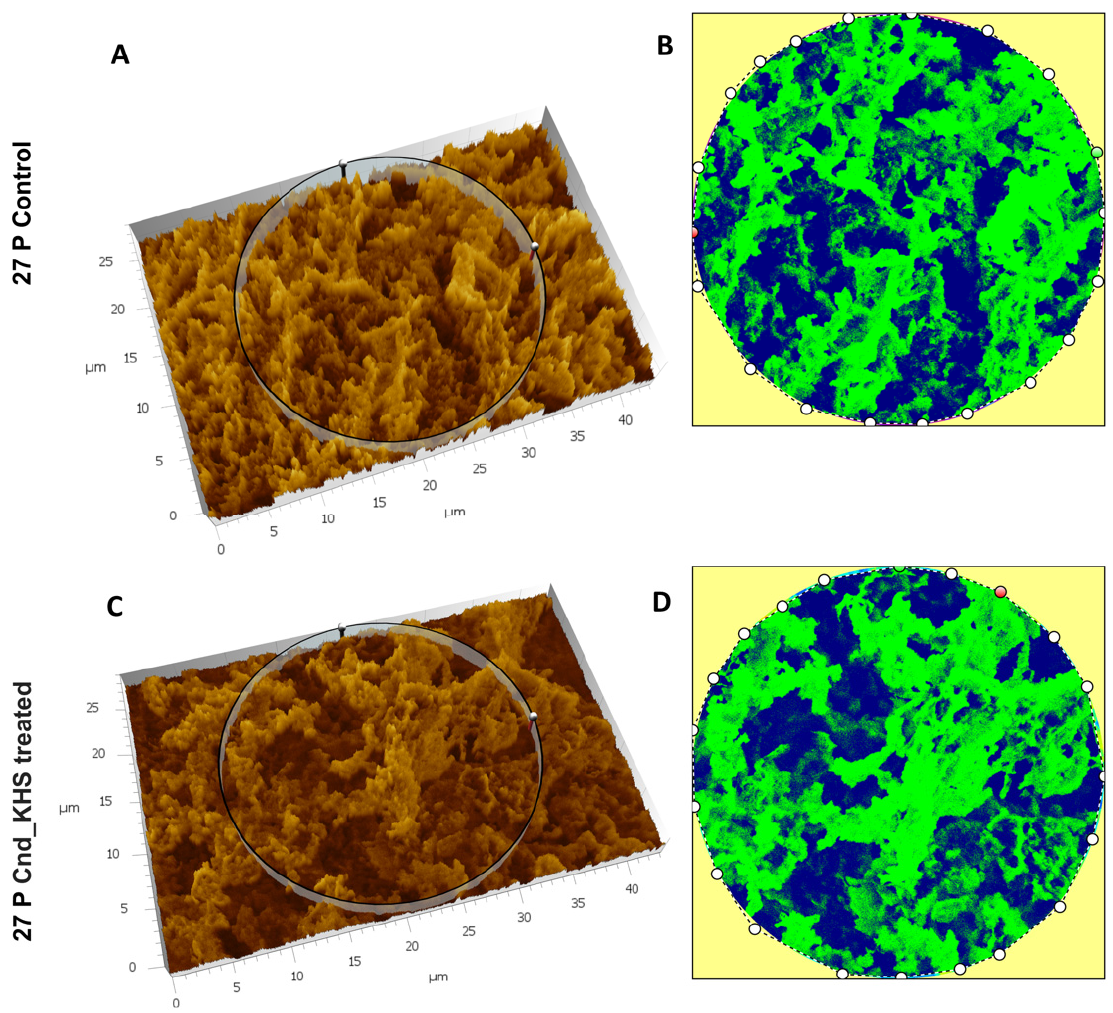
Figure 5. Three-dimensional reconstruction and analysis of P. aeruginosa 27P ( A , B ) and P. aeruginosa 27P treated with KHS-Cnd ( C , D ). The magnification is 3.00 K. ( A ) The spongy surface of untreated P. aeruginosa 27P biofilm was imagined in 3D. ( B ) The circle represents the extracted area shown in false colors and related to untreated 27P. ( C ) The spongy surface of KHS-Cnd treated P. aeruginosa 27P biofilm was imagined in 3D. ( D ) The circle represents the extracted area shown in false colors and related to KHS-Cnd treated 27P. High elevated areas corresponded to the edges of the laminae of ECM meshes and are colored in green. The labyrinthic channel system is represented in blue.